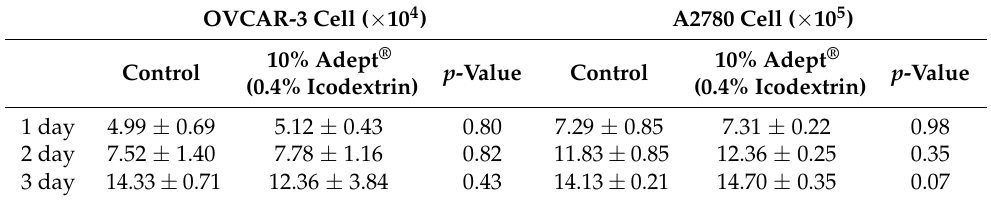
Table 2. Time-dependent effect of 10% Adept ® on the cell growth of OVCAR-3 and A2780